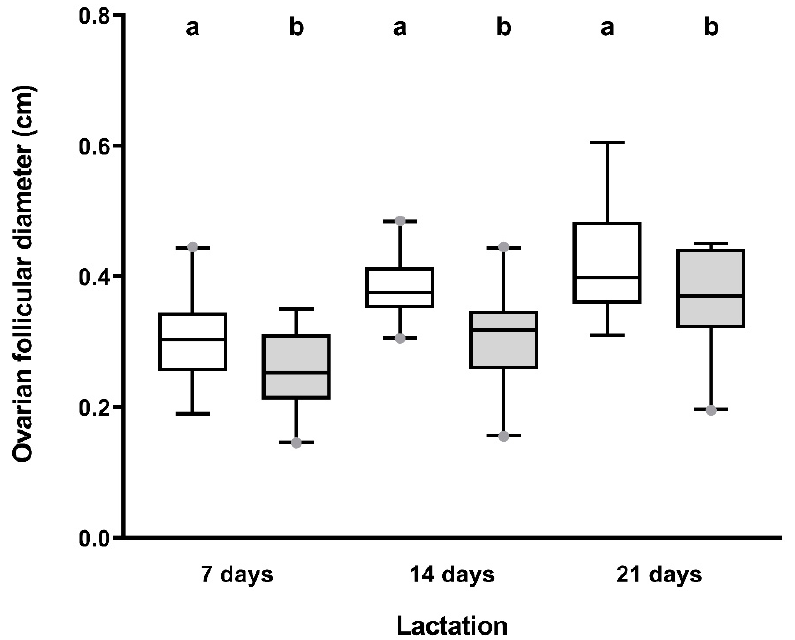
Figure 5. Box–whisker plots showing the ovarian follicular diameter during lactation in sows nursing during winter–spring (white boxes) or summer–autumn (grey boxes). Boxes enclose the 25th and 75th percentiles; the line is the median; and the whiskers extend to the 5th and 95th percentiles. Grey dots show outliers. a and b indicate differences ( p < 0.05) between season in each measurement days.